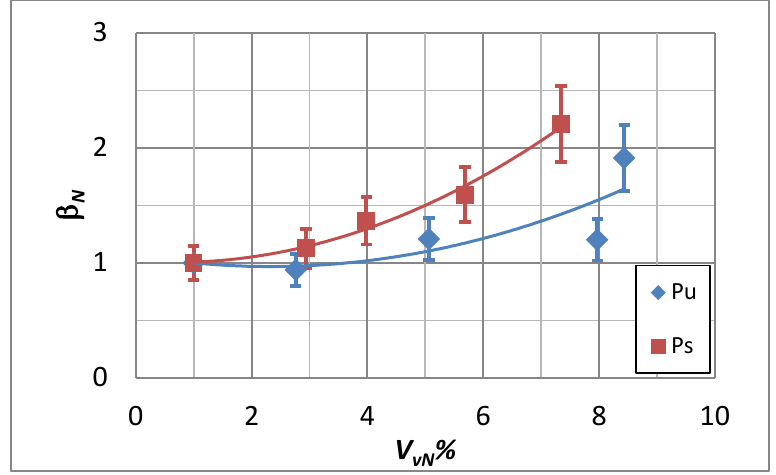
values against V N